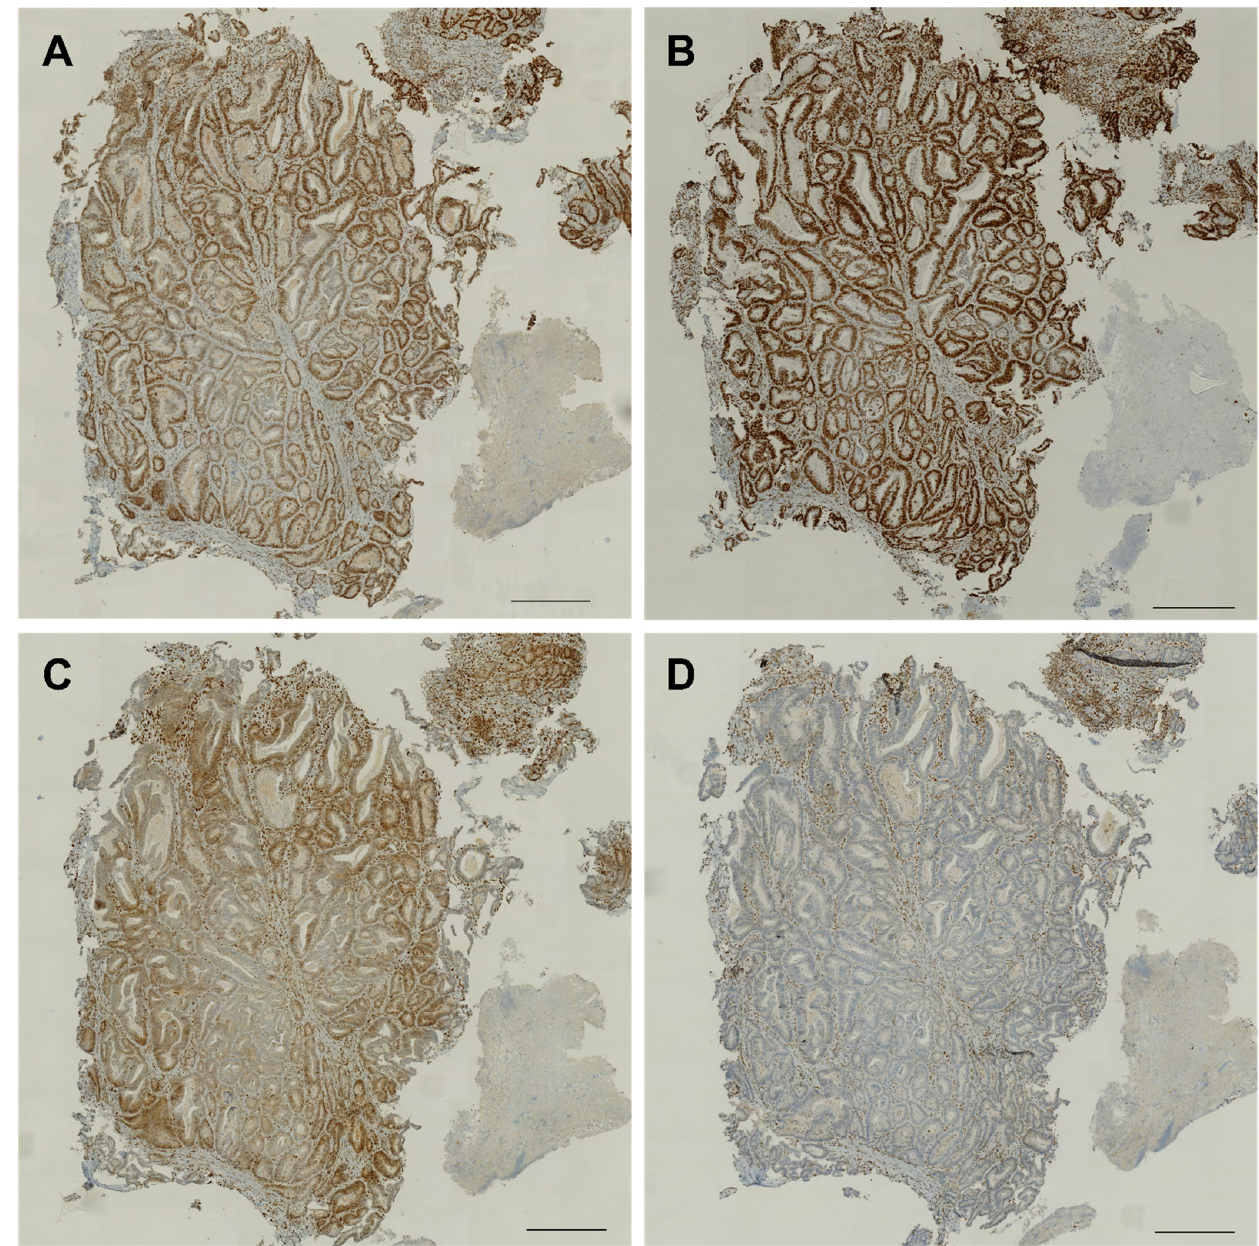
Figure 4. Immunohistochemical analysis of mismatch repair protein complexes in gastric biopsy. Gastric mucosa staining positive for MLH1 ( A ), PMS2 ( B ), and MSH6 ( C ), and lost expression of MSH2 ( D ). Scale bar indicates 100 µm.